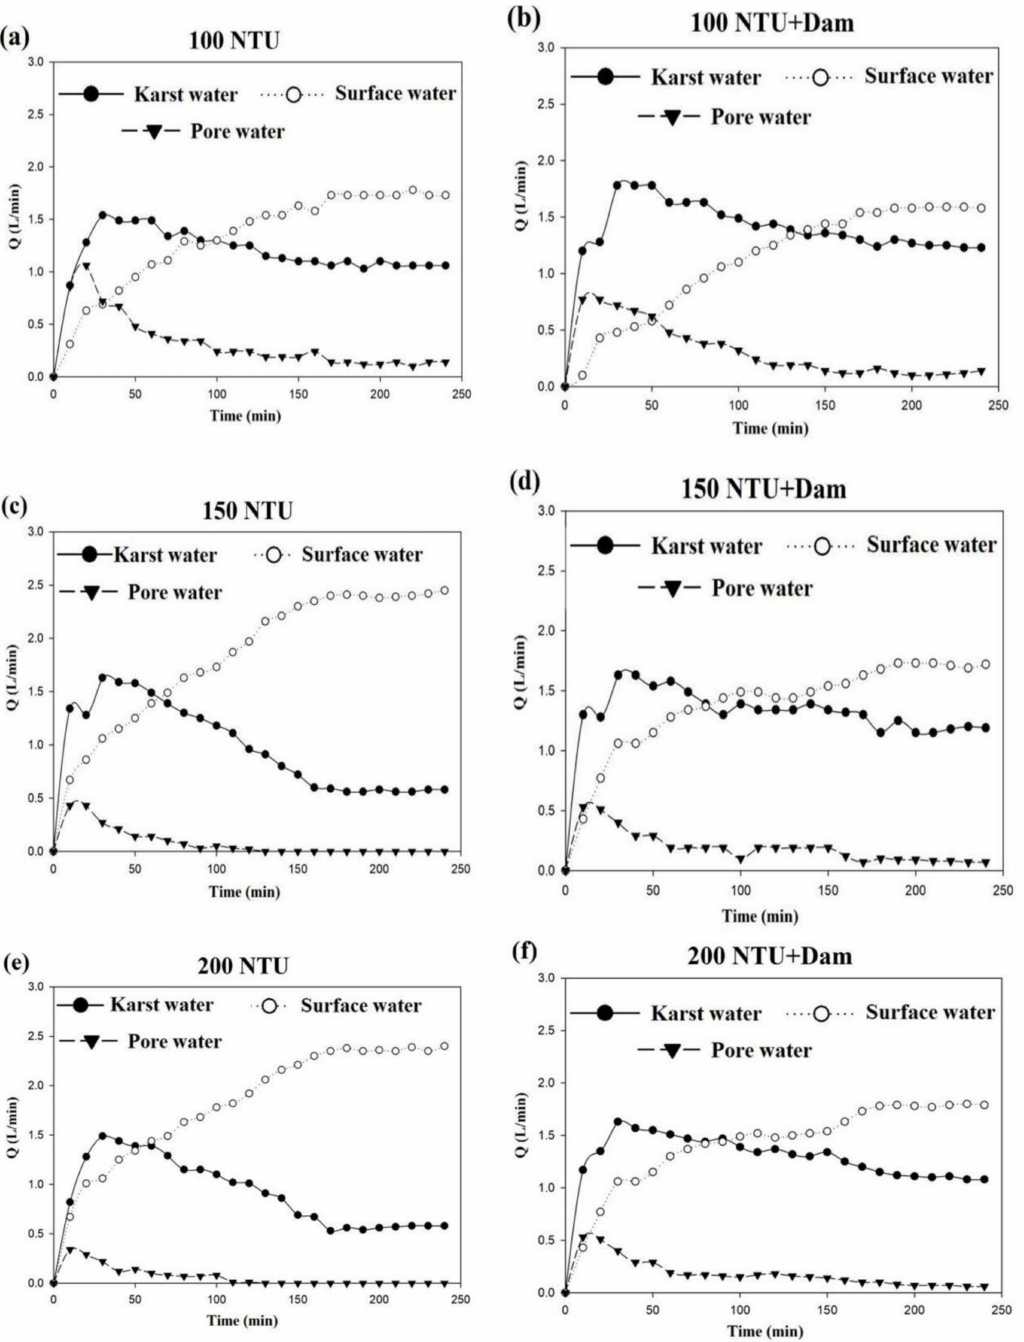
Figure 6. ( a , c , e ) Flow curves of surface water, pore water, and karst water when the turbidity of recharge water is 100, 150, and 200 NTU, respectively. ( b , d , f ) Flow curves of surface water, pore water, and karst water when the turbidity of recharge water is 100, 150, and 200 NTU, respectively, after the rubber dam is built in the